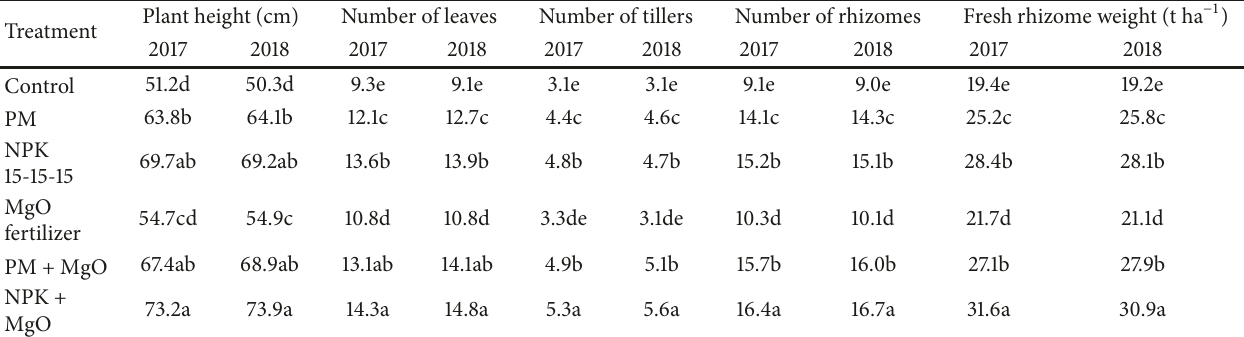
Table 4: Effect of Mg fertilizer, PM, NPK fertilizer, and their combinations on performance of turmeric. Treatment